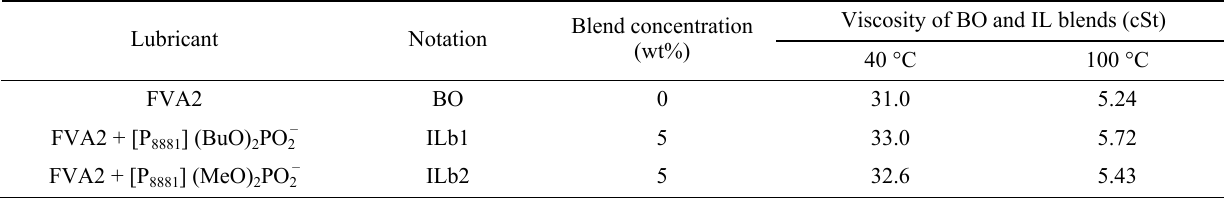
Table 2 Blend concentrations and viscosities of the BO and IL